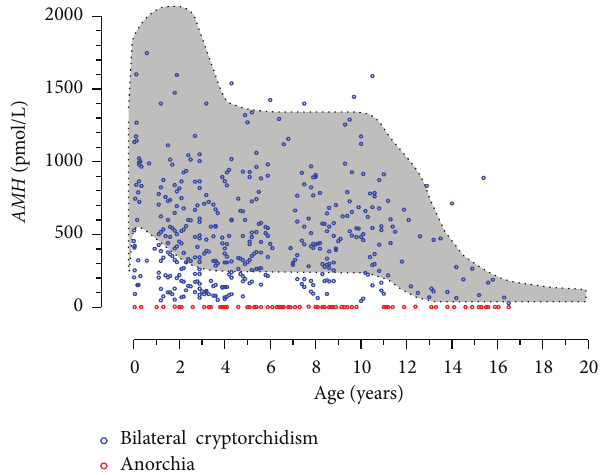
Figure 3: Serum AMH levels are useful to distinguish between bilateral cryptorchidism with abdominal testes and anorchism. Serum AMH is undetectable in anorchid patients; in patients with bilaterally abdominal testes, serum AMH is always detectable rang- ing from subnormal to normal values according to the functional statusofthegonads.ShadedarearepresentsthenormalserumAMH range (3th–97th centiles), according to